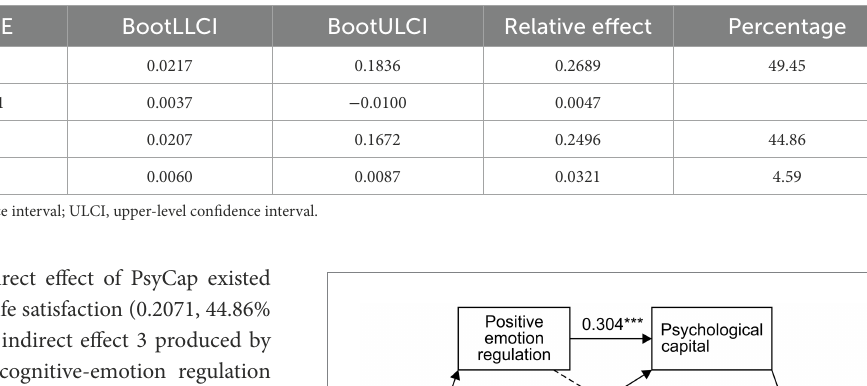
TABLE 7 Analysis of the mediation effect.